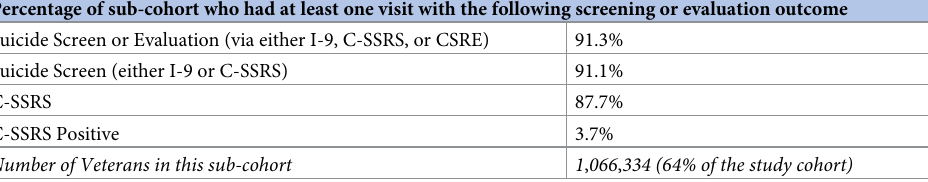
Table 3. Patterns of screening or evaluation by for Veterans who had at least one mental health visit in the post- universal screening implementation period. Percentage of sub-cohort who had at least one visit with the following screening or evaluation outcome Suicide Screen or Evaluation (via either I-9, C-SSRS, or CSRE)